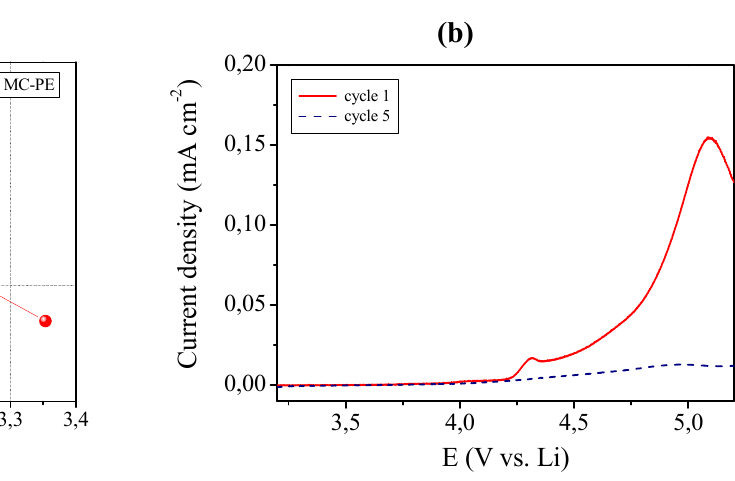
Figure 7. ( a ) Ionic conductivity versus temperature plot of the MC-PE reinforced quasi-solid polymer electrolyte. Data obtained by impedance spectroscopy; ( b ) Current vs . voltage curves at room temperature for